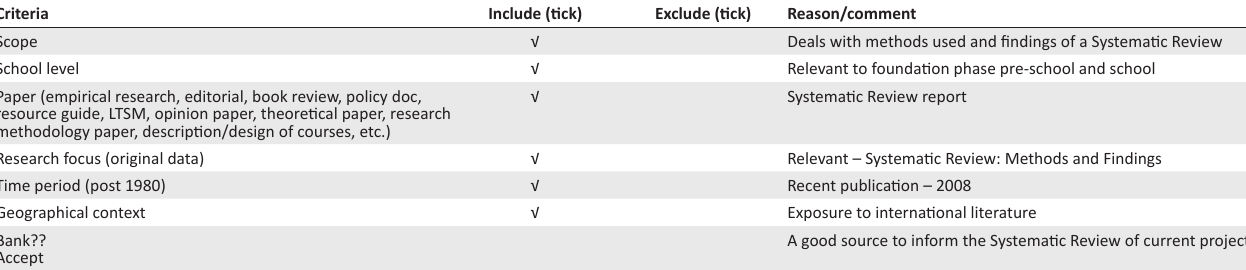
TABLE: 2-A4 : FPP – Version 2 screening template.